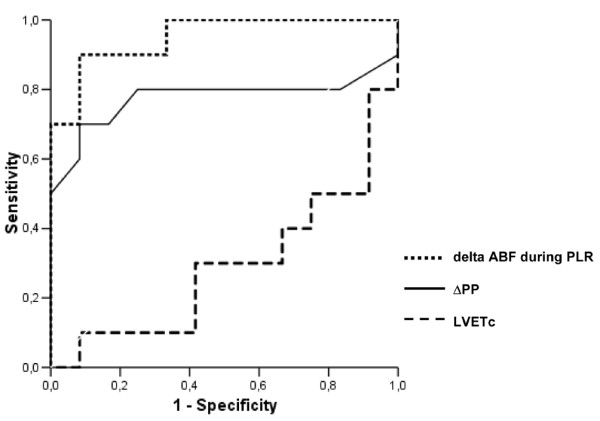
ROC curves comparing delta ABF, LVETc and ΔPP to discriminate responders and non-responders. Abbreviations: ROC = Receiver Operating Characteristic; ABF = aortic blood flow; PLR = passive leg raising; LVETc = left ventricular ejection time corrected for heart rate; ΔPP = respiratory variation of pulse pressure.